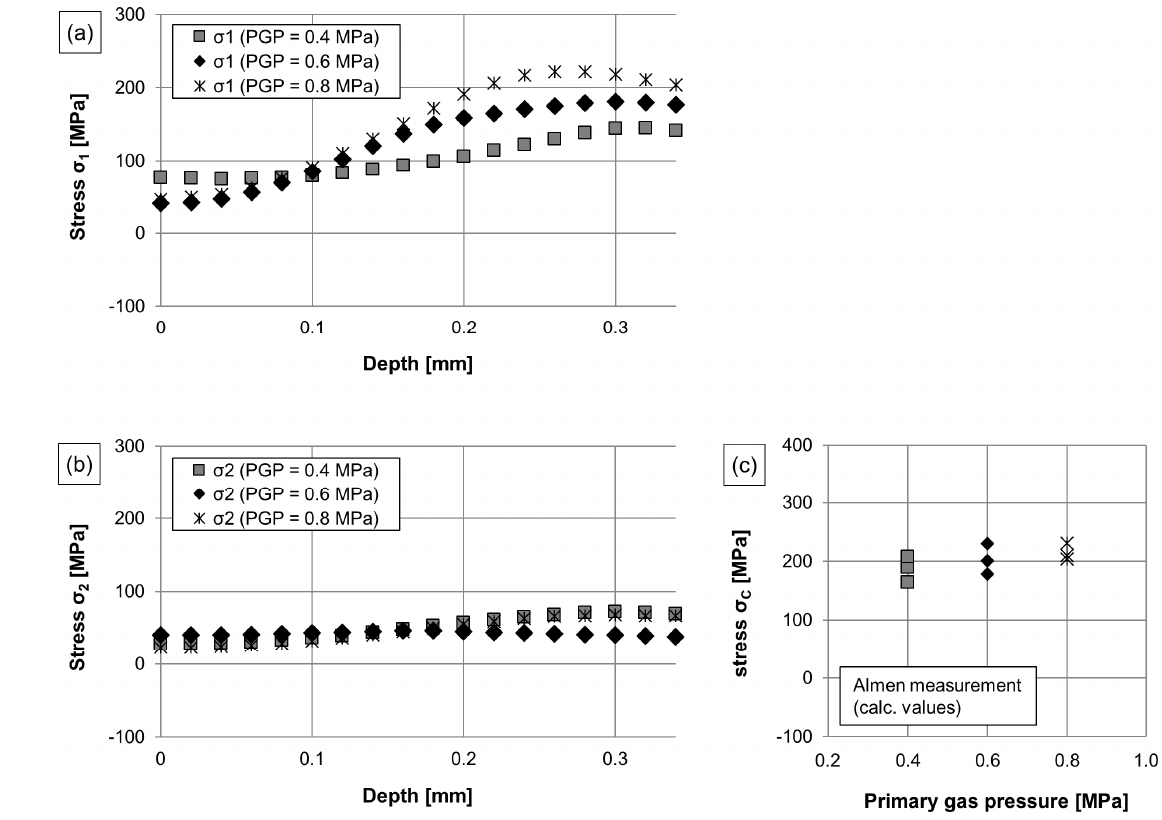
Figure 10. Residual stress distribution along coatings produced with different PGP, determined by using the bore hole drilling strain gage method ( a , b ), and calculated stress states in coatings produced with different PGP using the curvature method ( c ).